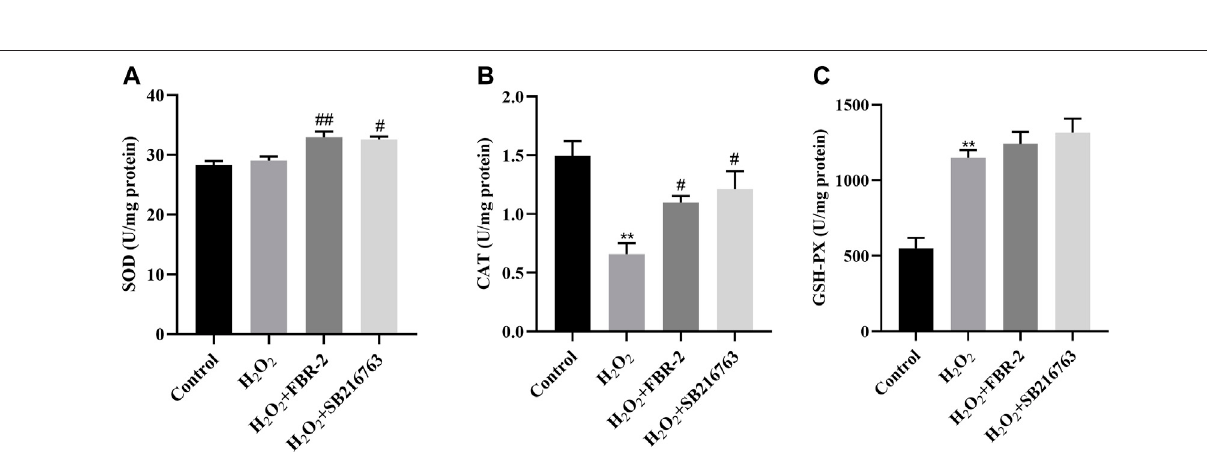
Frontiers in Pharmacology |